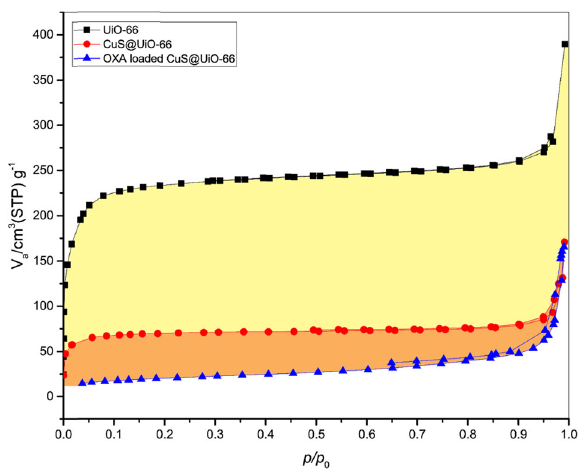
Fig. 3 The BET analysis of samples Table 1 Surface area, pore size, and total pore of the UiO-66-NH 2 , CuS@UiO-66-NH 2 , and OXA-CuS@UiO-66-NH 2